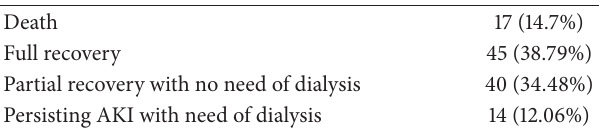
Table 6: Outcome of AKI at